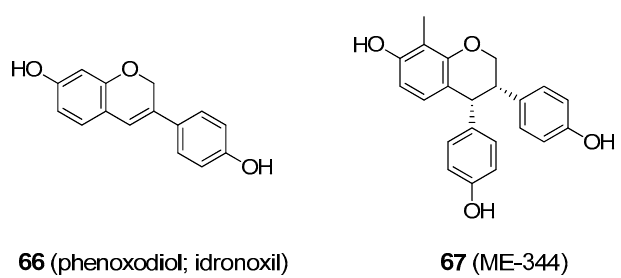
Figure 16. Some of the simple isoflavan derivatives that showed promising anticancer activity.